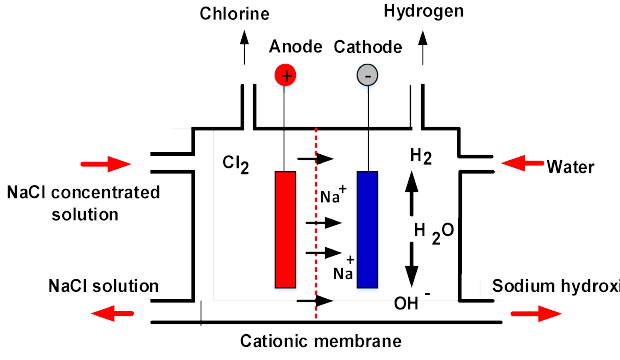
Figure 2. Membrane cell